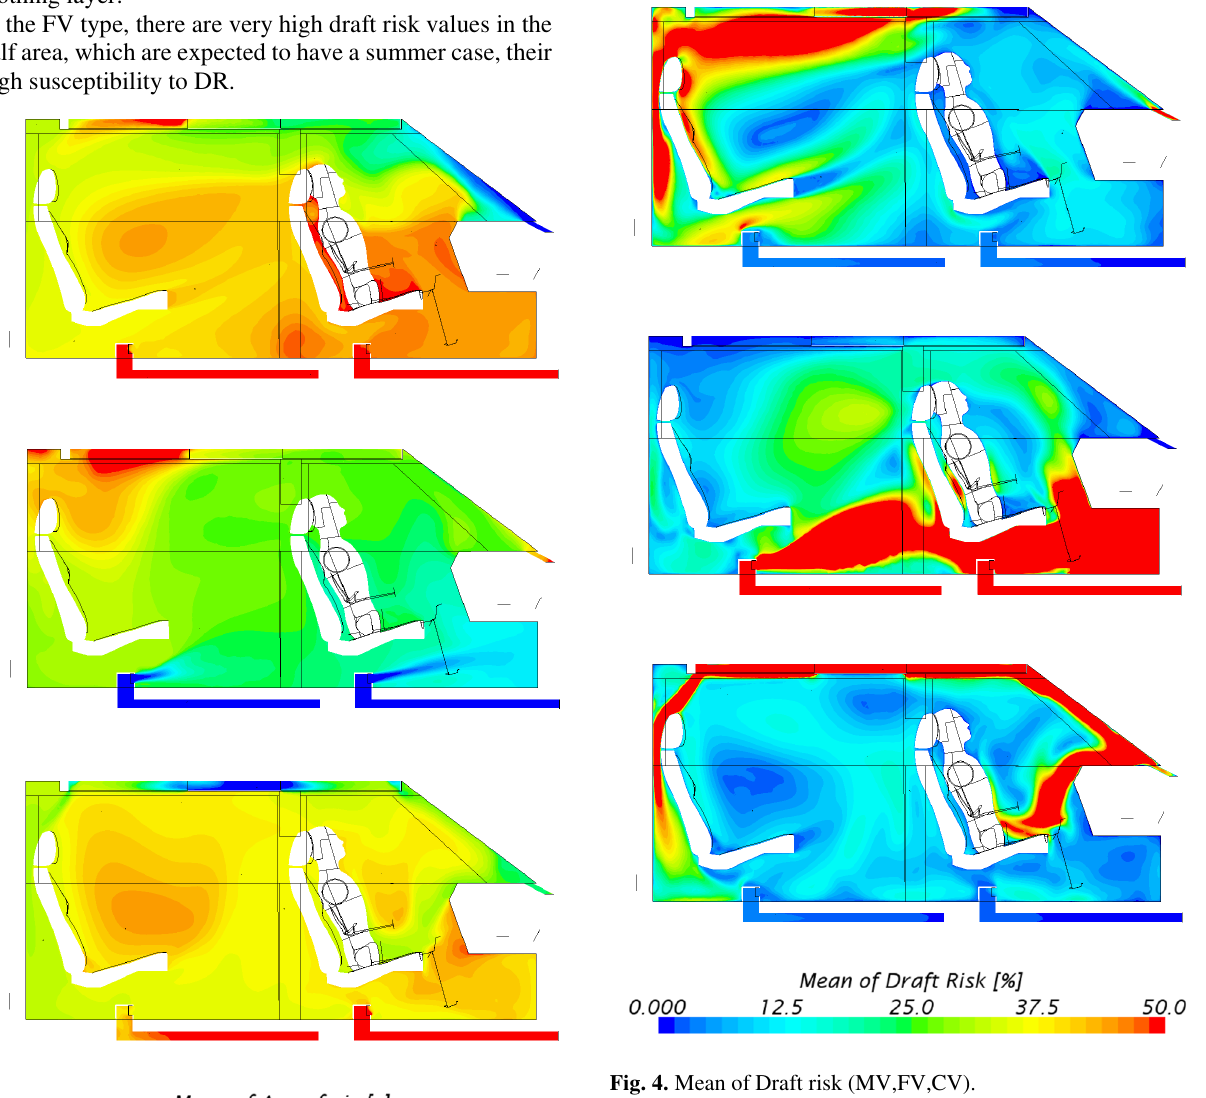
Fig. 4 . Mean of Draft risk (MV,FV,CV)